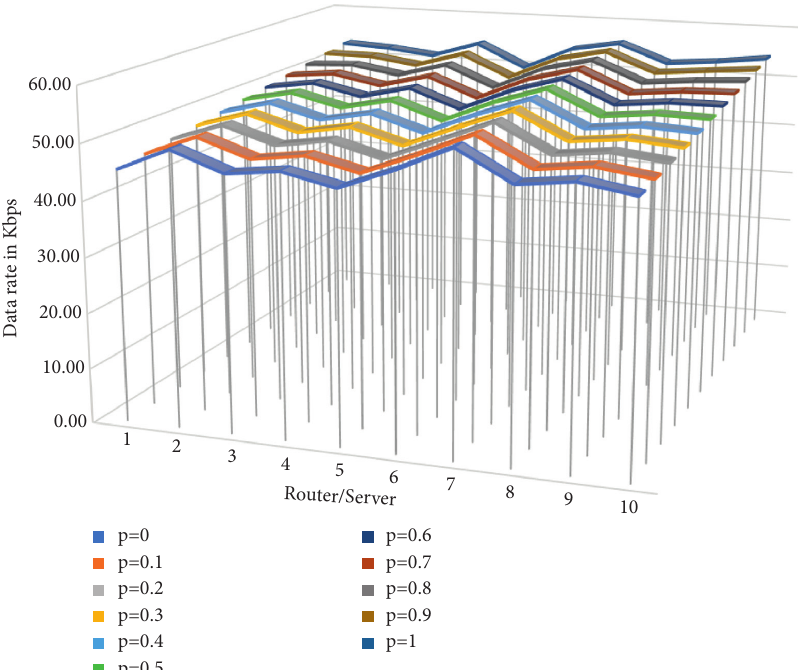
Figure 4: Graphical representation of data stream rate when α � 0.